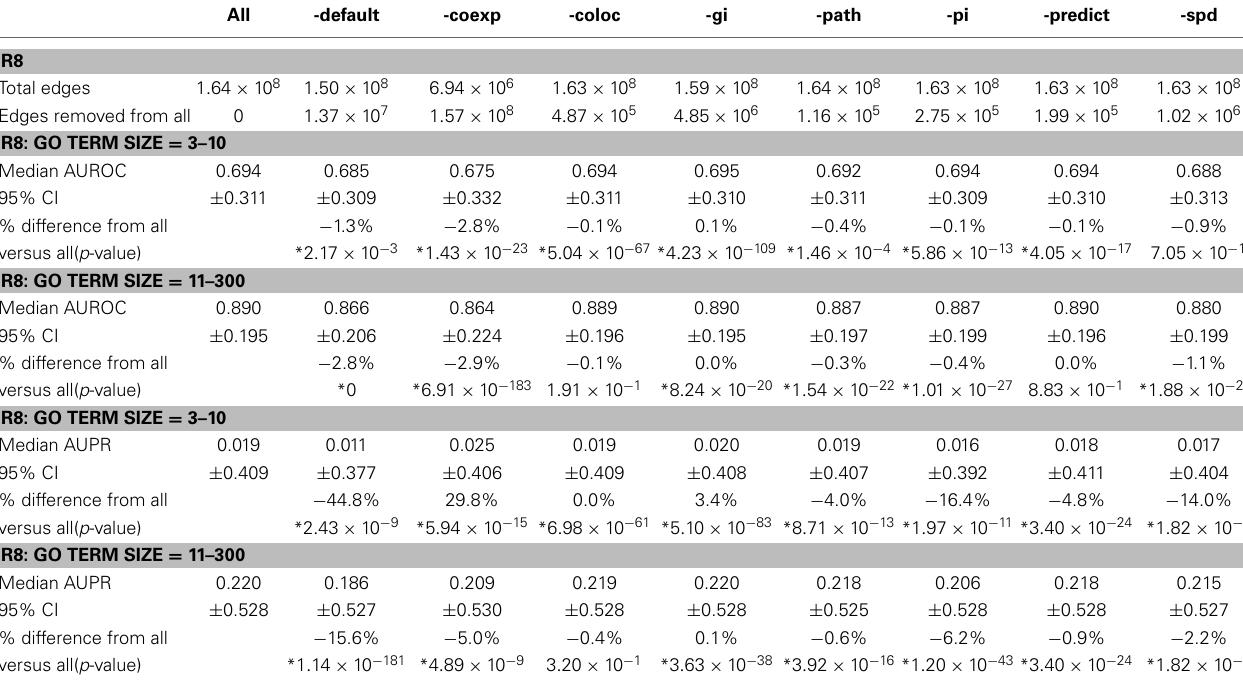
Table 2 | Median AUROC and AUPR for R8 when all networks are used (All) compared to when default (-default), co-expression (-coexp), co-localization (-coloc), genetic interaction (-gi), pathway (-path), physical (protein) interaction (-pi), predicted (-predict), and shared protein domain (-spd) networks are removed,